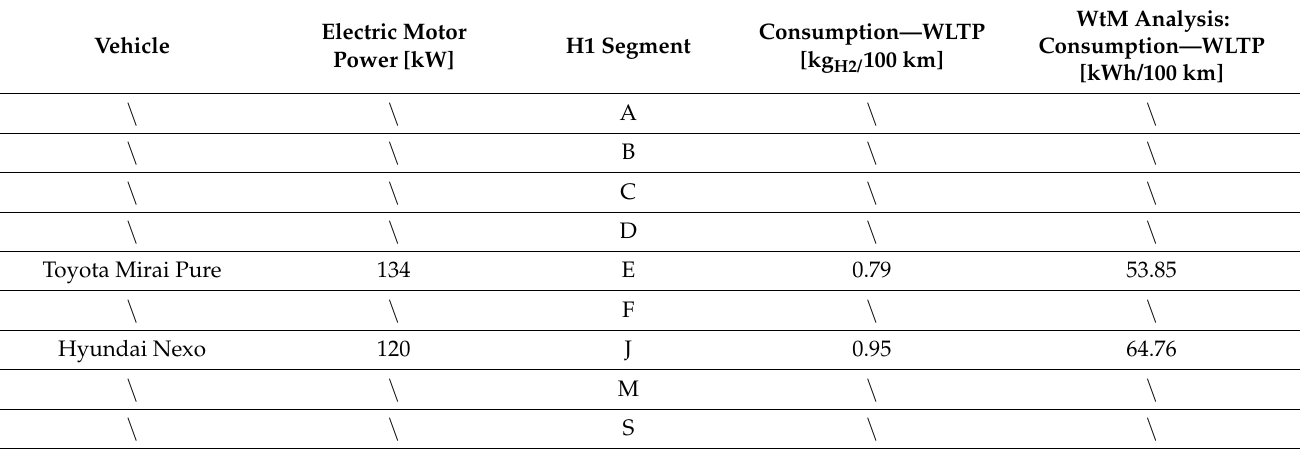
Table 11. Passenger vehicle fleet in Europe: division into powertrain and H1 segments—Powertrain: FCV [15,17,18] fed by hydrogen.